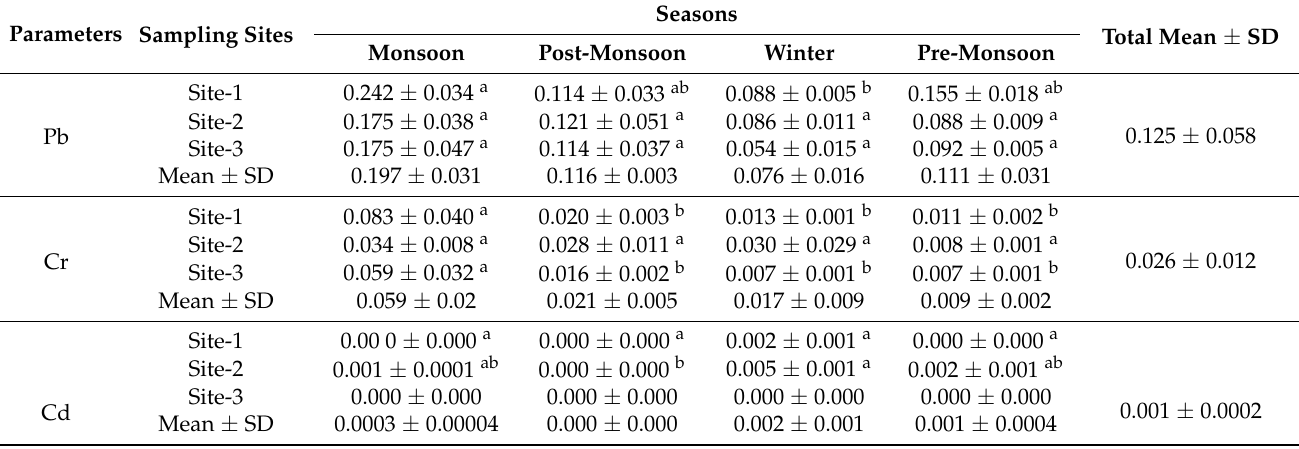
Table 3. Heavy metal concentrations (mg L − 1 ) in water sample of Hakaluki haor at different study sites (Data presented as mean ±